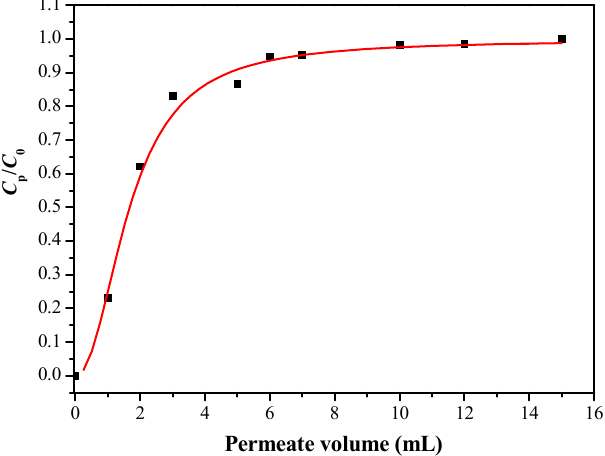
Figure 14. Breakthrough curve of PSF-diol membrane (C 0 = 5 mg/L, pH = 8).